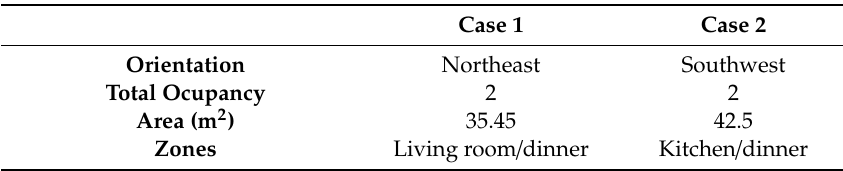
Table 2. Design properties of each case of study